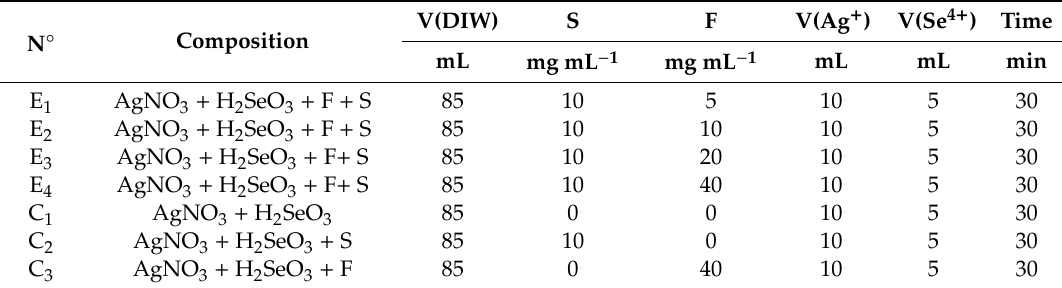
Table 2. Reaction parameters to produce Ag 2 Se NPs in a 100 mL reaction